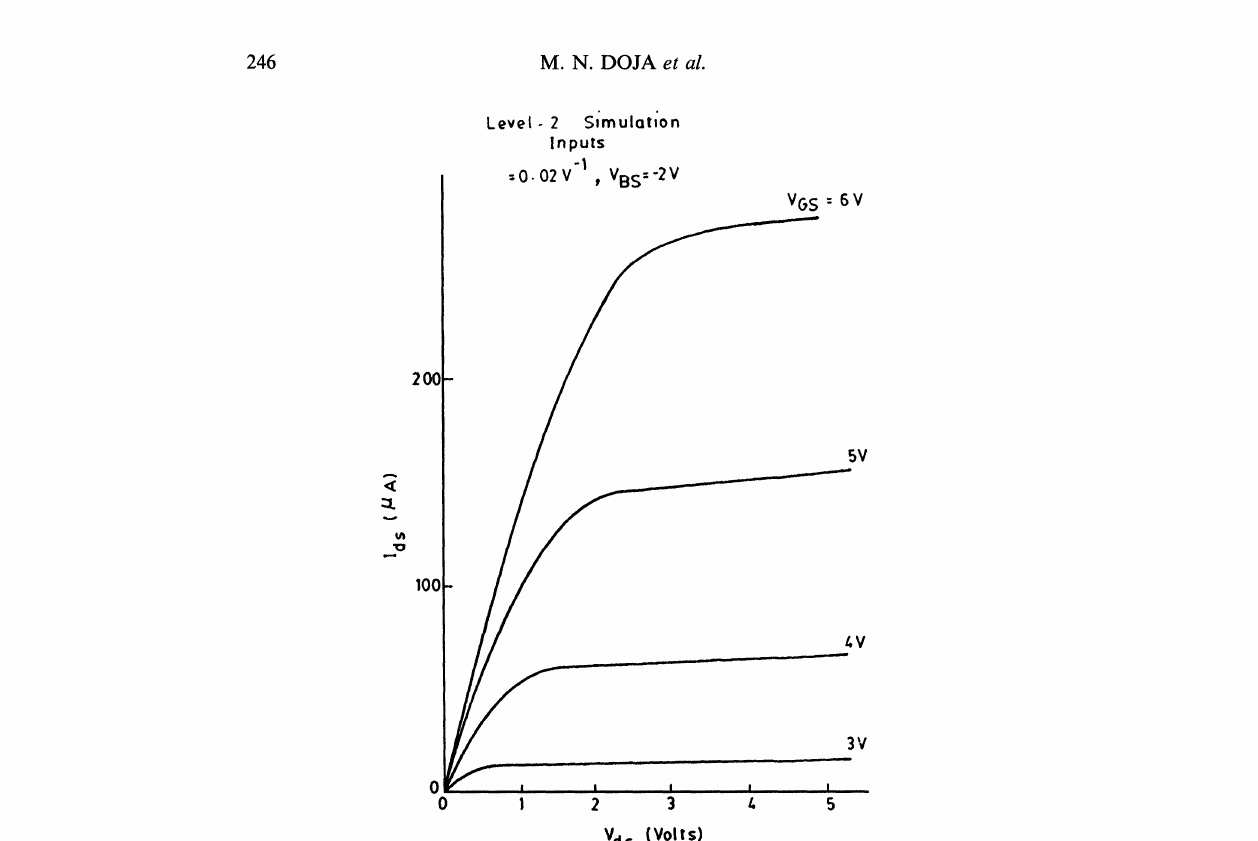
FIGURE 11 Graph drawn by using MOSOFT equations for the values of the various parameters as